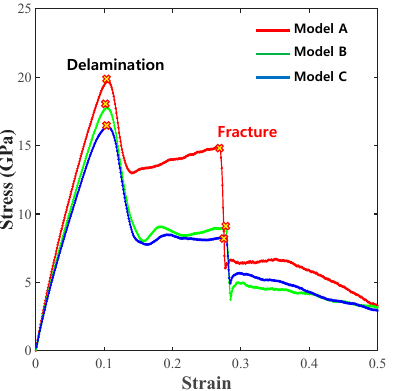
σ – ε results for models A, B, and Figure 6. Armchair direction σ– ε results for models A, B, and C. Figure 6. Armchair direction Figure 6. Armchair direction σ– ε results for models A, B, and C.